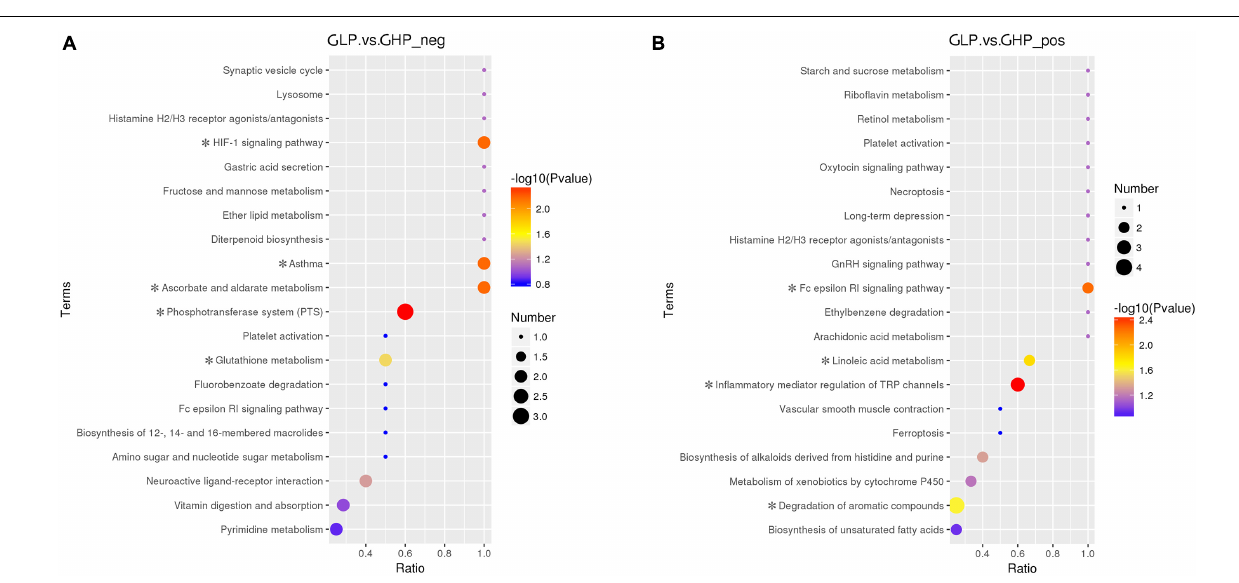
FIGURE 6 | KEGG pathway enrichment of the differentially abundant metabolites between the two gilt groups. ∗ P < 0.05, (A) LC-MS (ESI-); (B) LC-MS (ESI+). GHP, gilts fed high protein diet; GLP, gilts fed low protein